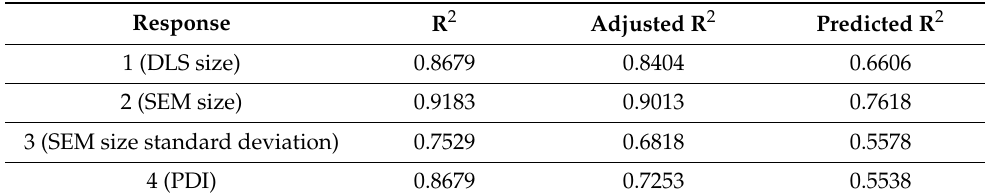
Table 3. Model statistics of the four responses.